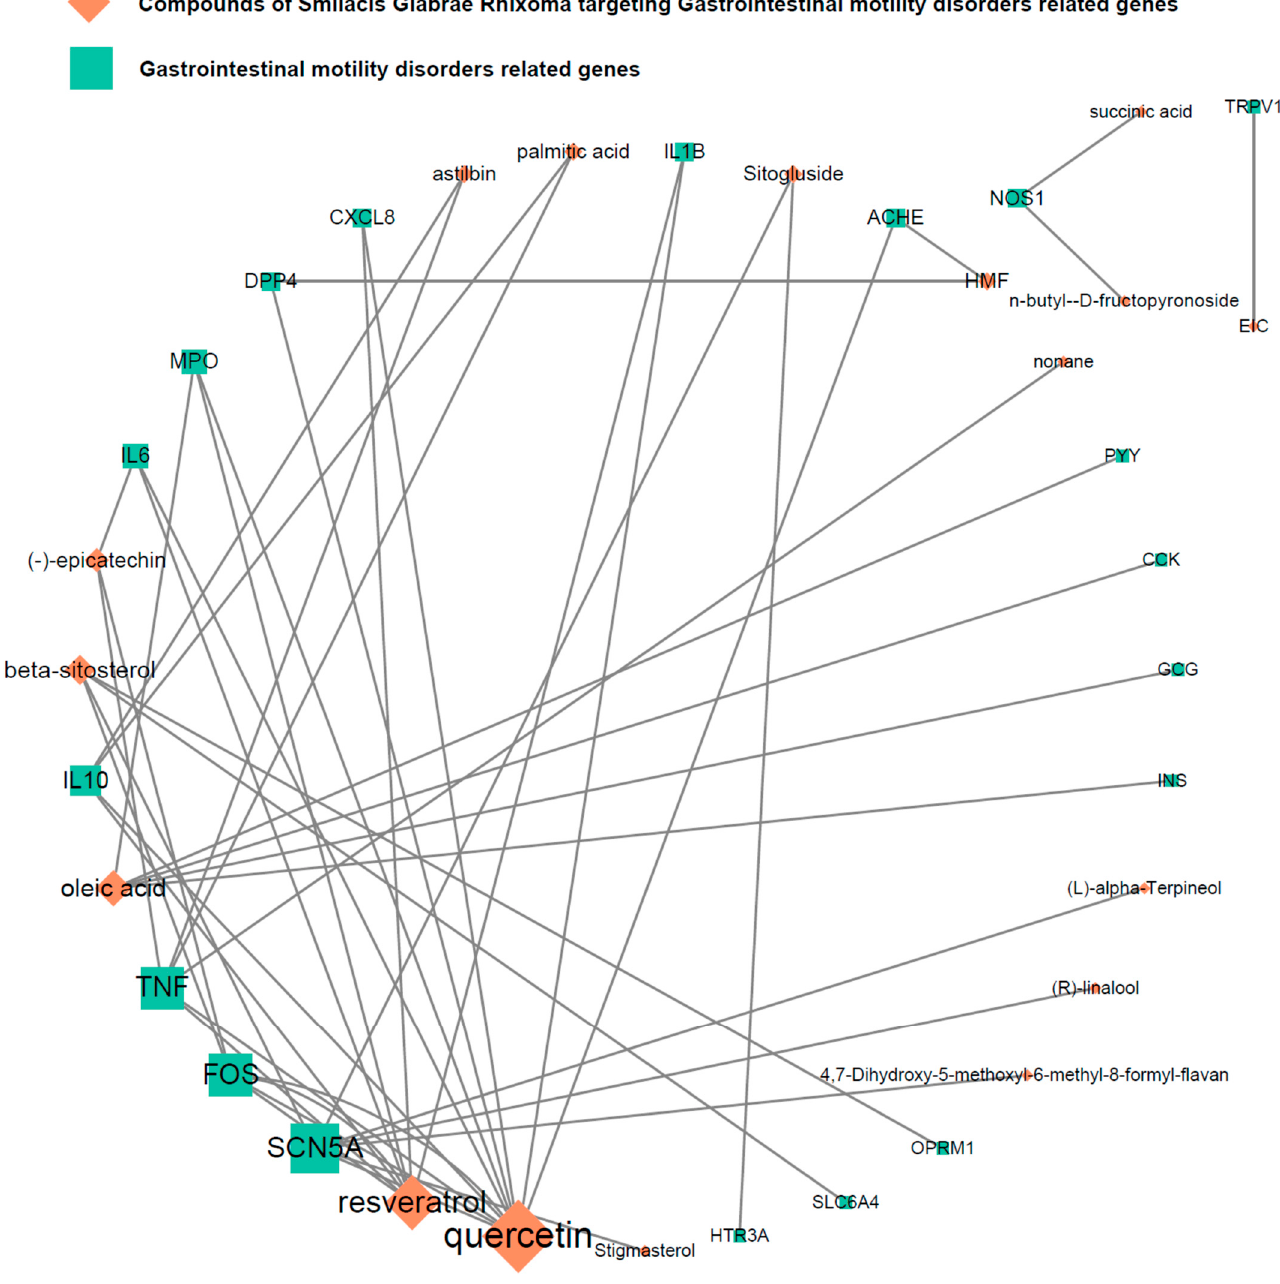
Figure 5. Network of compounds of SGR and GMD related genes. GMD: Gastrointestinal Motility Disorder. SGR: Smilacis Glabrae Rhixoma.